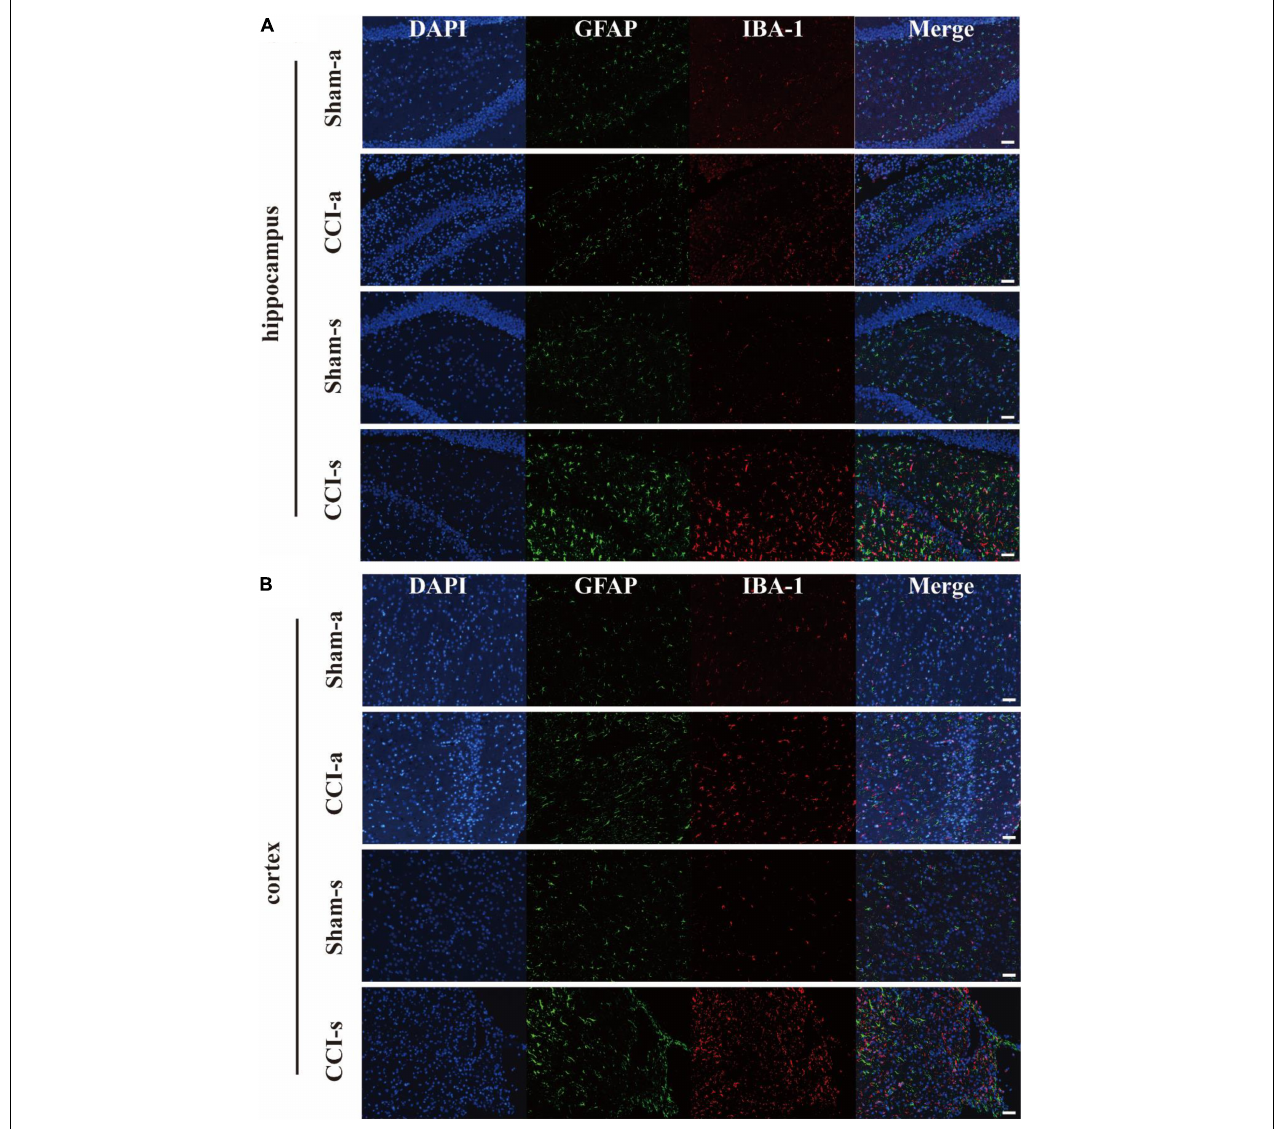
FIGURE 4 | The activation of astrocyte and microglia after severe TBI. GFAP antibody and IBA-1 antibody are specific for astrocytes and microglia, respectively. (A) Representative immunofluorescent staining for GFAP (Green) and IBA-1 (Red) in the injured hippocampus. (B) Representative immunofluorescent staining for GFAP (Green) and IBA-1 (Red) in the injured cortex. Scale bar = 50 µ